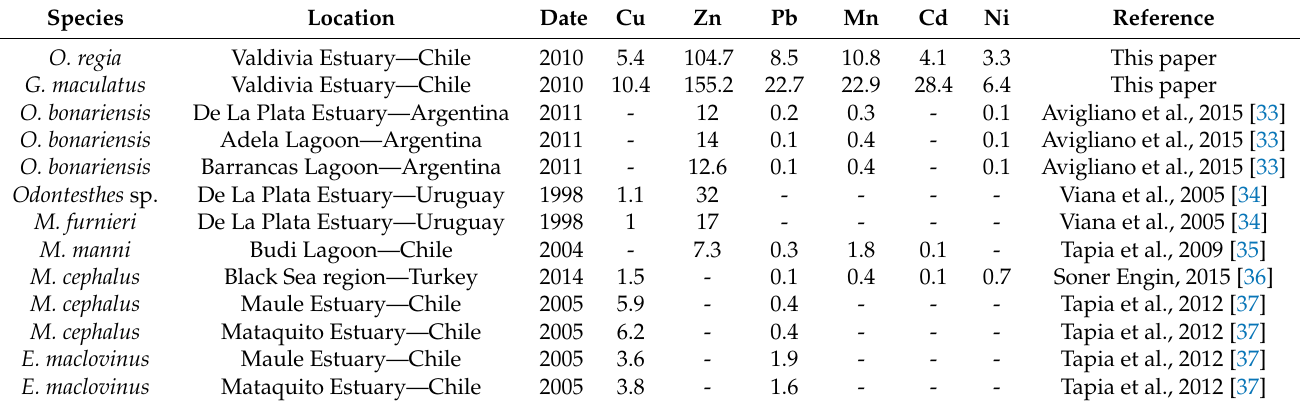
Table 5. The concentration ( µ g/g) levels of heavy metals in whole samples of Odontesthes regia and Galaxias maculatus from this study, and concentration of heavy metals in the muscle of other estuarine